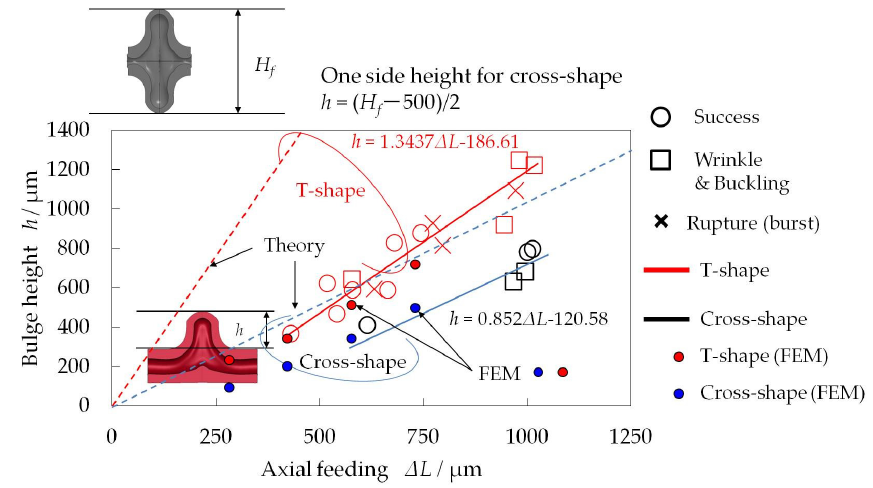
Figure 27. Theoretical and experimental results showing relationship between bulge height and amount of axial feeding for T ‐ shape and cross ‐ shape hydroforming (C1220).